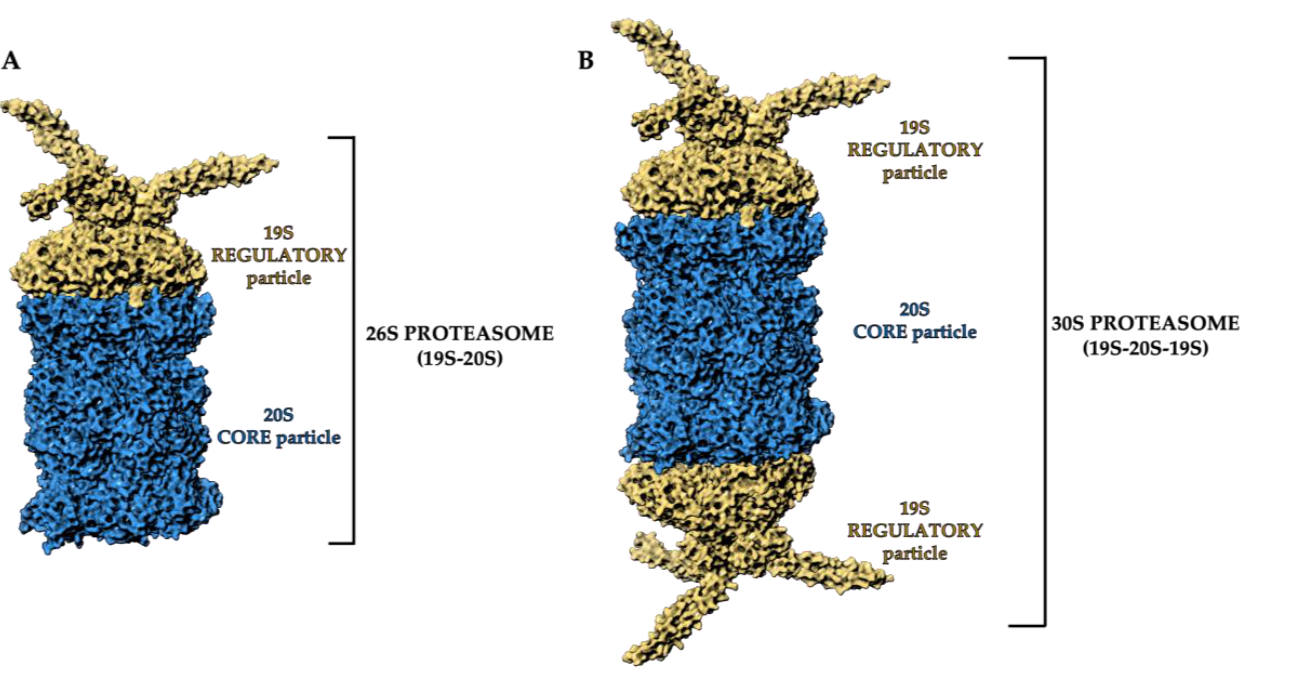
Figure 1. Three-dimensional representation of ( A ) 26S proteasome and ( B ) 30S proteasome structure. The 19S regulatory particles and the 20S core particle are shown as yellow and blue areas, respectively. Atomic coordinates were obtained from PDB model 5MP9 [29]; the figure was built by means of Maestro graphical interface [30] .